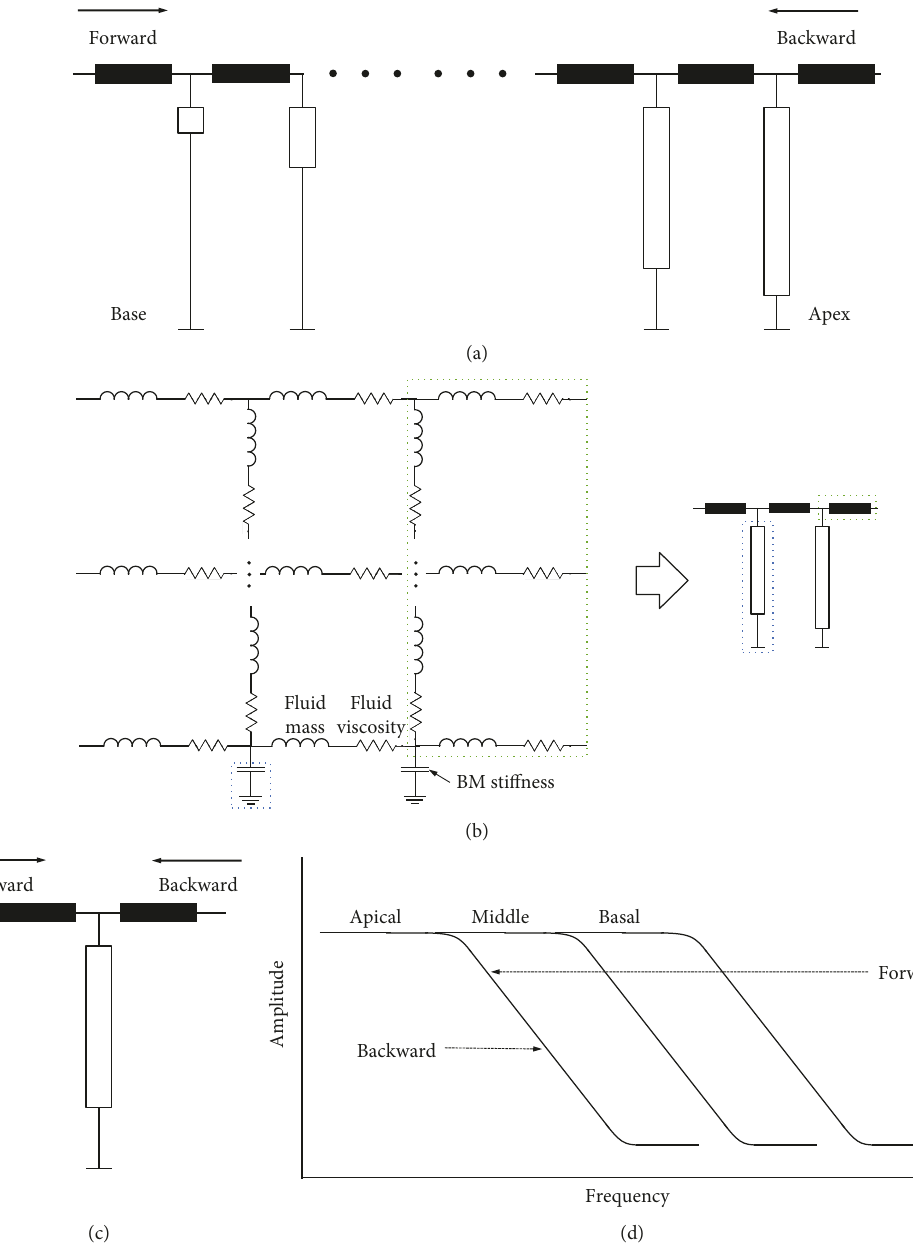
Figure 3: Model of the cochlear passive hydromechanical structure. (a) Schematic of the model structure. The thick solid lines represent the fl uid channel and the open rectangles represent the cochlear partition, or simply BM. In this lumped model, the fl uid channel and the cochlear partition (or simply BM) were divided into a series of sections. The rectangle is wider and shorter at the base and thinner and longer at the apex, representing the BM sti ff ness gradient: sti ff er at the base and softer at the apex. (b) Circuit analogy of each section. The fl uid mass is analogous to a series of inductors; the fl uid viscosity is analogous to a series of resistors; the sti ff ness of the partition is analogous to a capacitor. (c) At each section, the forward and backward waves experience the same low-pass fi ltering. (d) Schematic shows the low-pass fi lters that the traveling wave experiences during the forward and backward propagation. Note that the forward direction is towards the low frequency. The roll-o ff frequency at the basal, middle, and apical locations